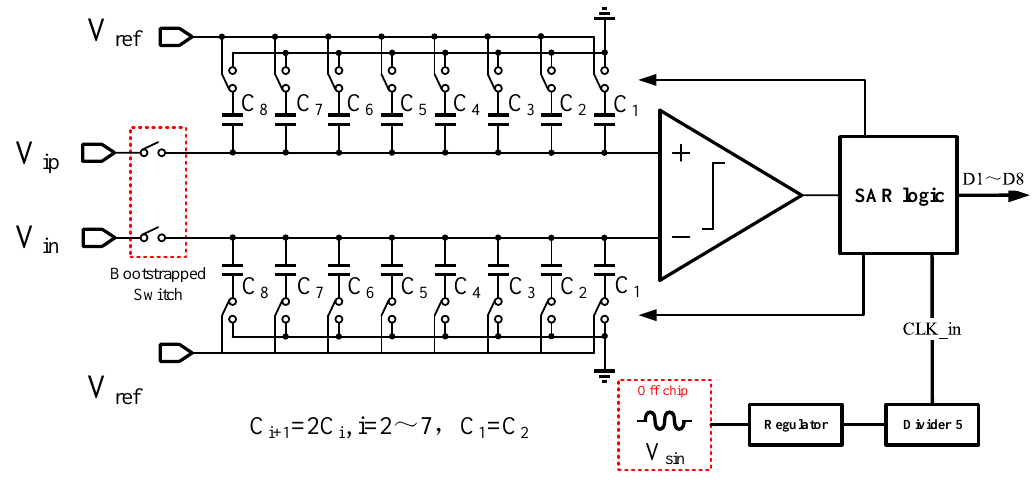
Figure 4. The proposed SAR ADC